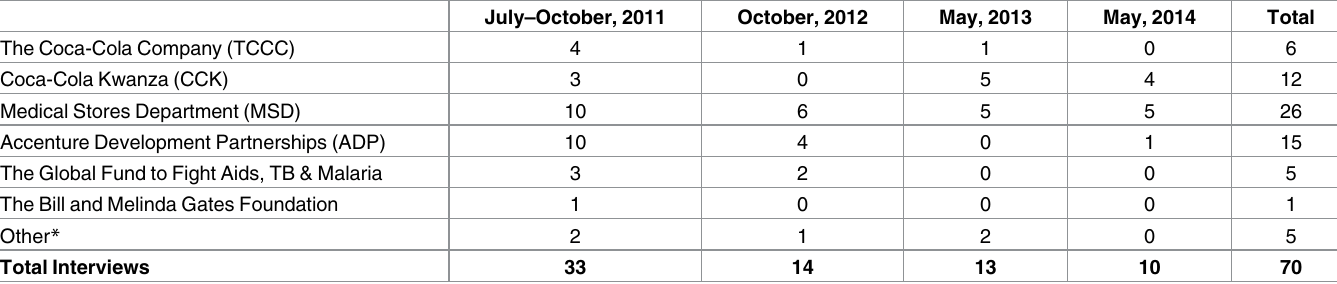
Table 2. Count of in-depth interviews by partner